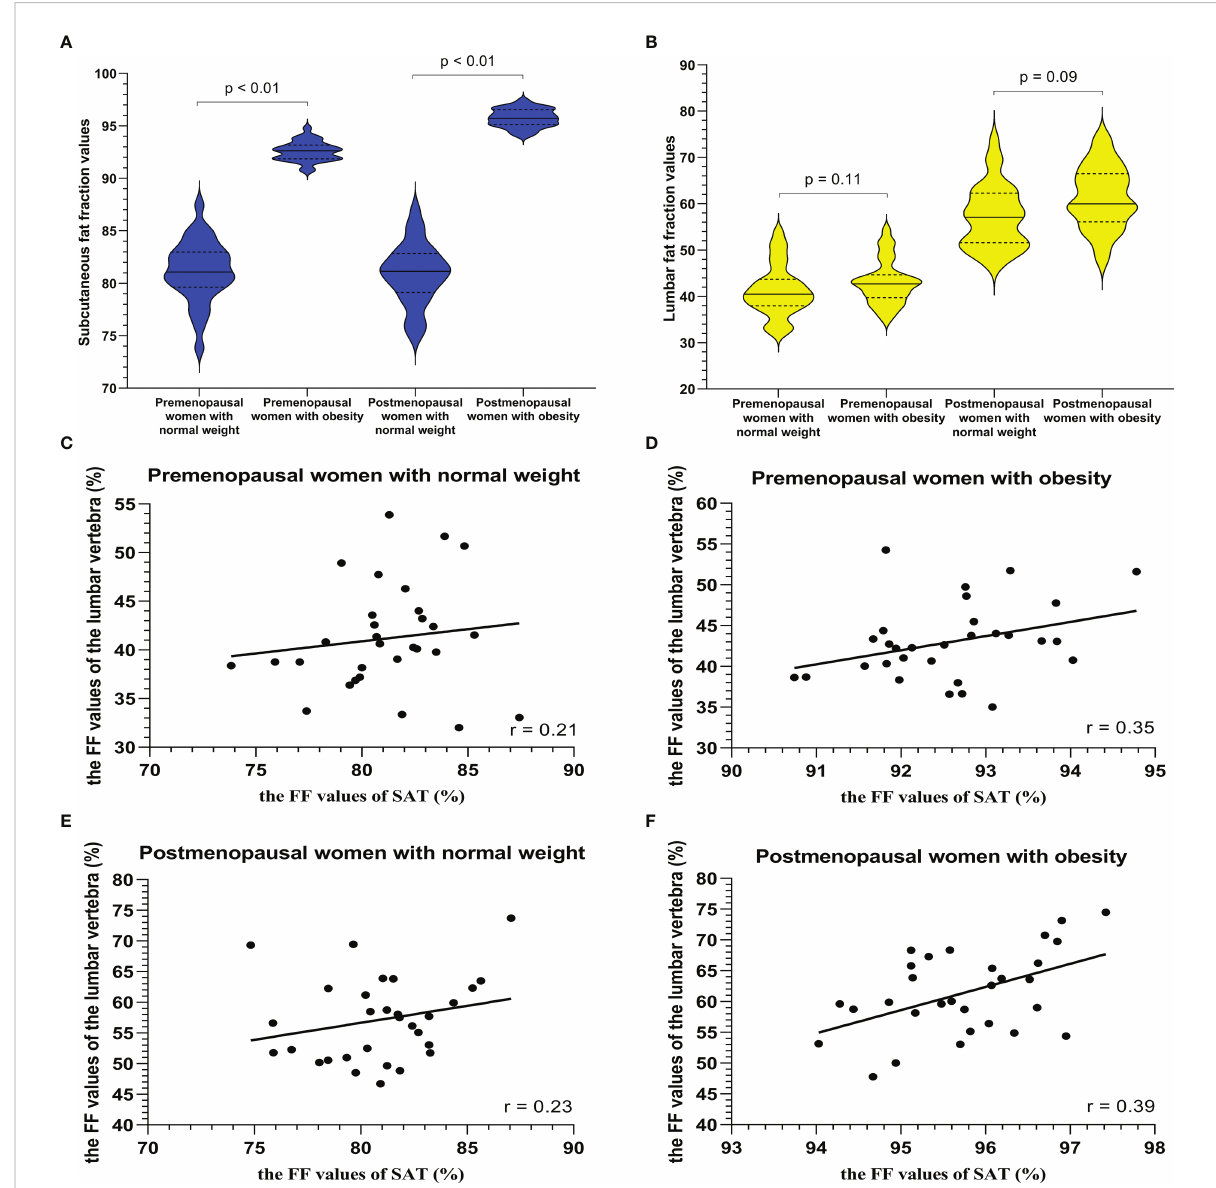
FIGURE 6 The violin plot analyzing fat fraction values for a subcutaneous site (A) and lumbar vertebra (B) in four groups (premenopausal women with normal weight, premenopausal women with obesity (BMI > 30 kg/m2), postmenopausal women with normal weight, and postmenopausal women with obesity (BMI > 30 kg/m2); 30 subjects in each group) con fi rmed that there is no statistical difference between the lumbar fat content of obese patients and that of normal-weight patients before menopause ( p = 0.11) and after menopause ( p = 0.09), and the subcutaneous fat content in the obese patients more than that in normal weight subjects ( p < 0.01). BMI = body mass index. The correlation plots for the correlations between FF lumbar and the FF SAT (C – F) The correlation between FF lumbar and the FF SAT in premenopausal or postmenopausal women without or with obesity was no different (C – F)